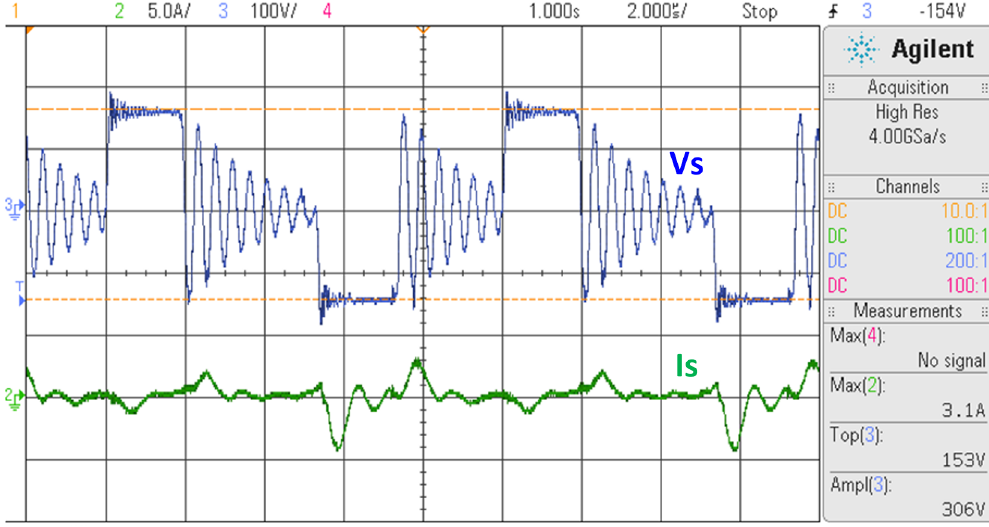
Figure 21. Transformer secondary characteristics: Blue—voltage, Green—current.